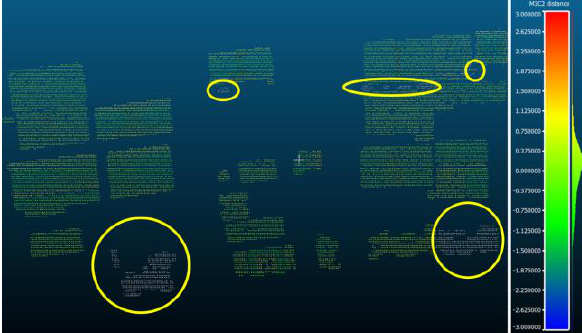
Figure 10. The 3D building change detection results. Building points coloured in grey depicts the new buildings and (sighed by yellow